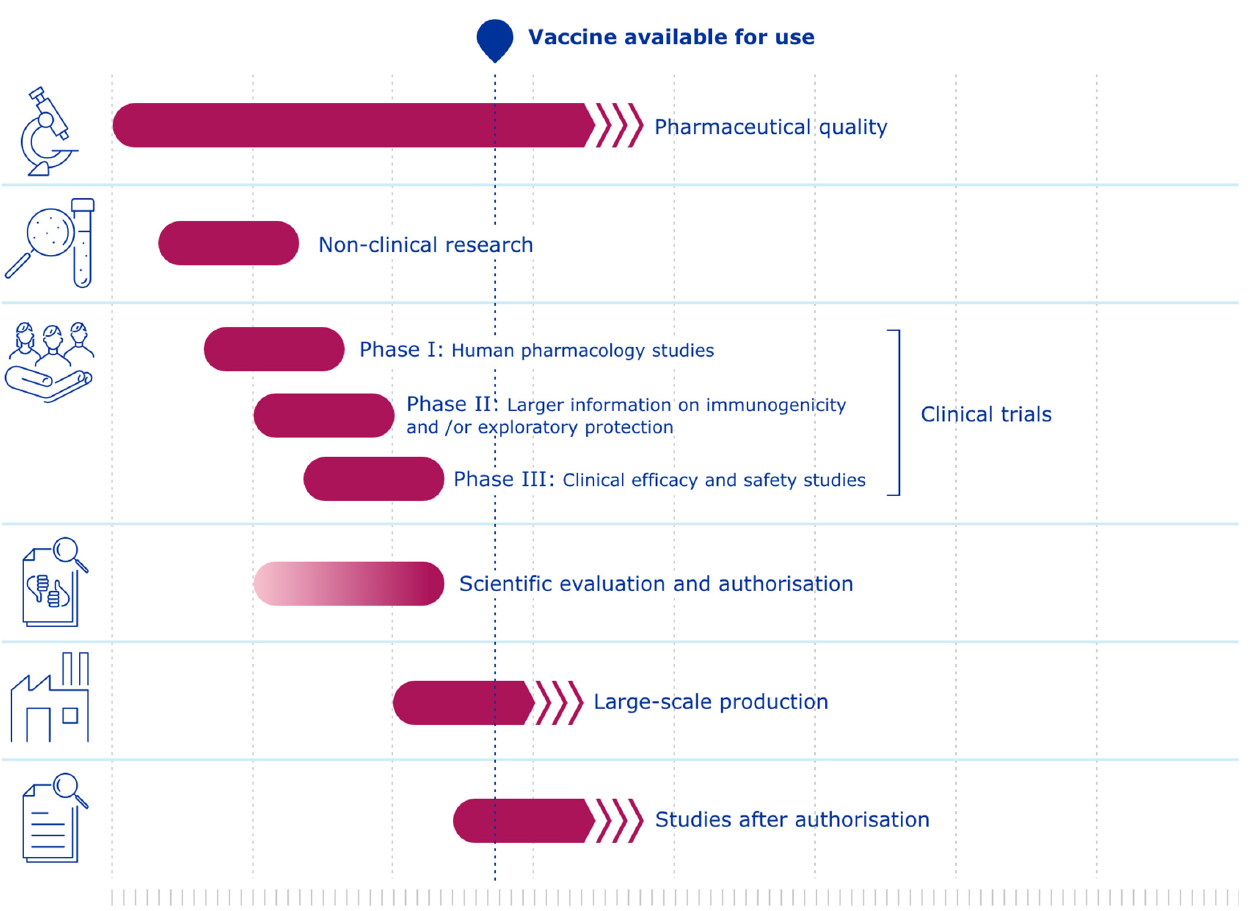
Figure 2. Vaccine development under ‘pandemic’ circumstances © EMA [1995–2022]